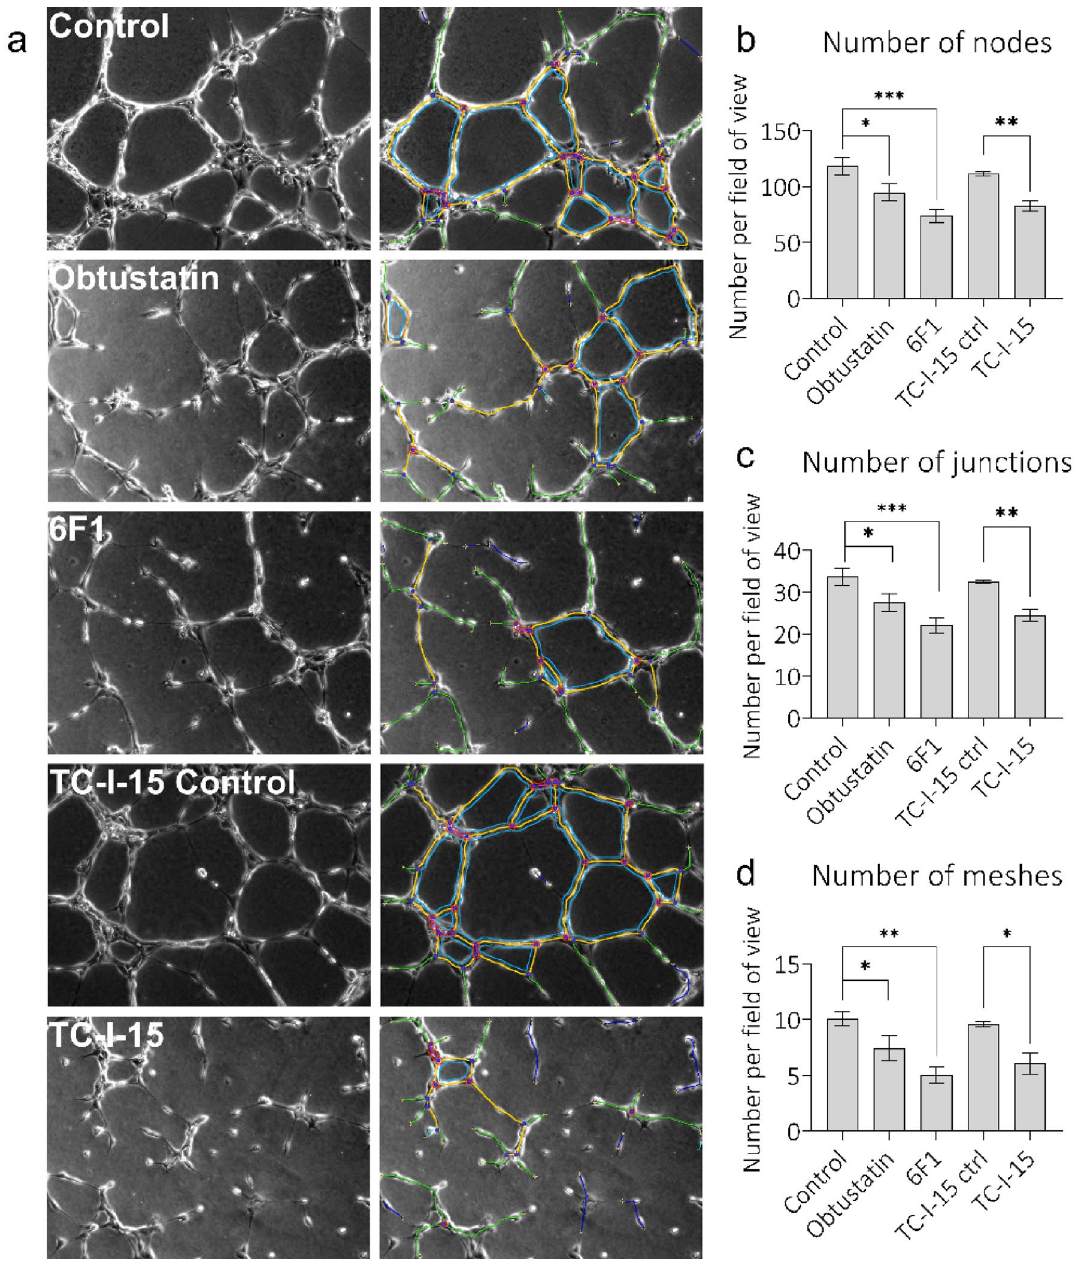
Figure 7. Quantification of tube formation after integrin inhibition. ( a ) Phase images taken 6 h after seeding cells in the presence or absence of inhibitors or vehicle controls. The left column of images indicates phase contrast images, the right column shows the angiogenesis analyser overlay. The quantification of ( b ) nodes, ( c ) junctions and ( d ) meshes. Error bars indicate SEM calculated from three repeats performed in